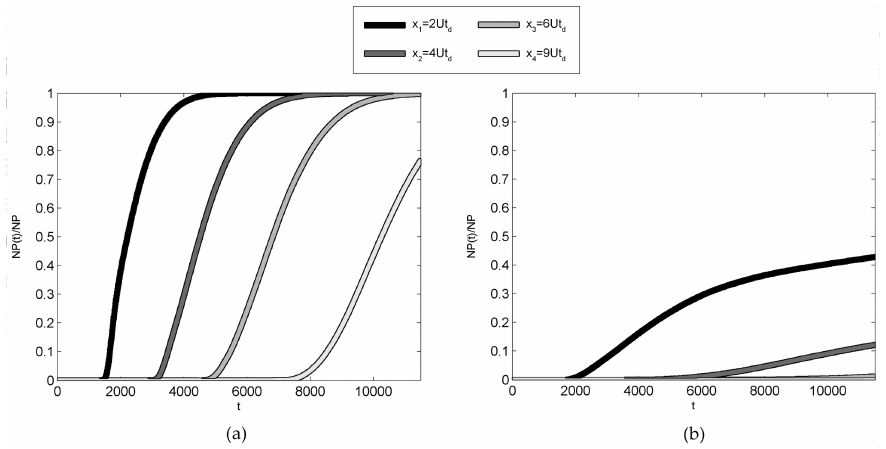
Figure 6. Breakthrough curves for R3. ( a ) Uniform mixing; ( b ) Non-uniform mixing.